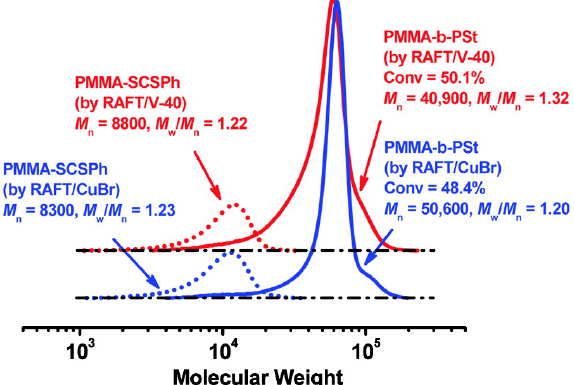
Figure 6. Concurrent ATRP and RAFT to eliminate new chain generation. Adapted with permission from [54], Copyright© 2008 American Chemical